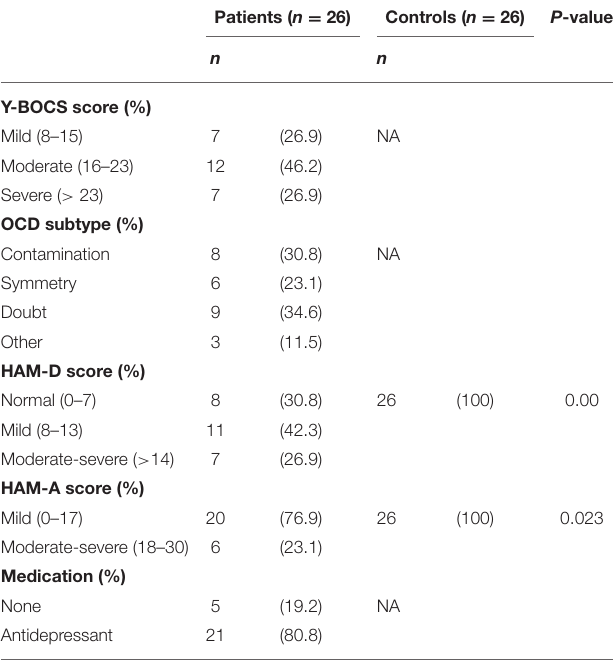
TABLE 2 | Clinical data of OCD patients and healthy controls.